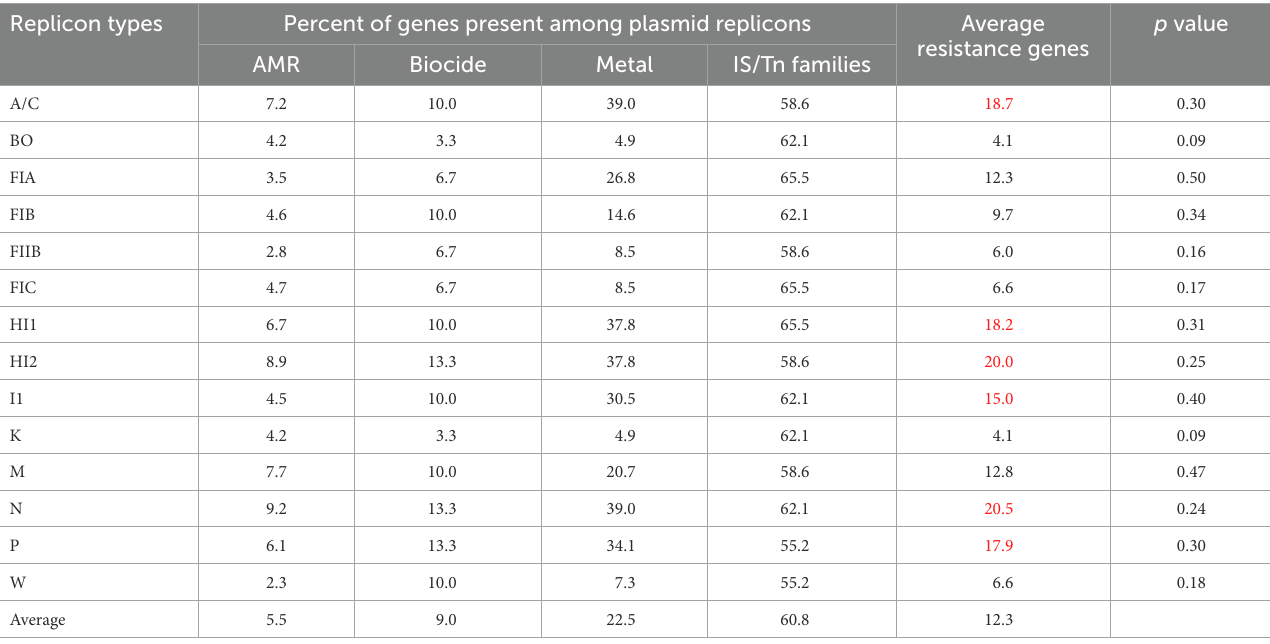
TABLE 4 Relative percentage of the different gene types compared to the number of corresponding genes in AMRFinderPlus (AMR: n = 983; Biocide: N = 30; Metal: N = 82) and ISFinder (N = 29). Replicon